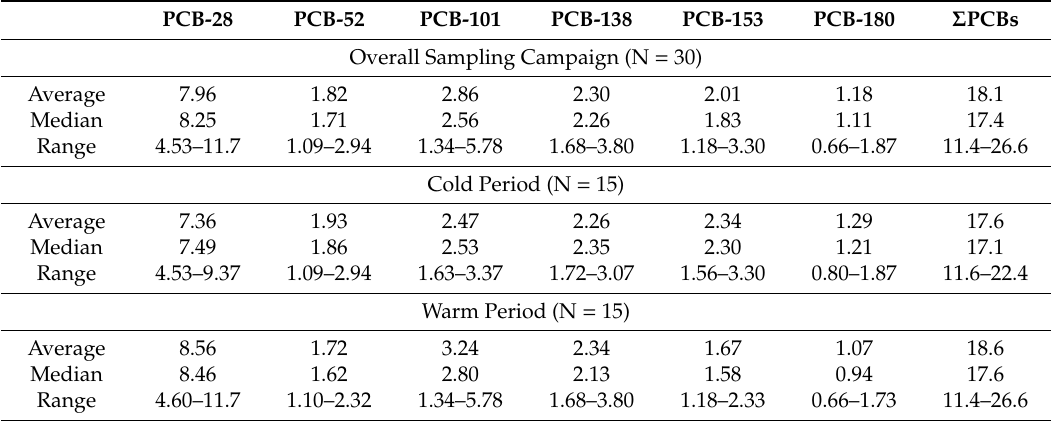
Table 2. Average, median, and ranged concentrations of indicator polychlorinated biphenyls (indPCBs) (pg m − 3 ) for the overall and seasonally divided sampling